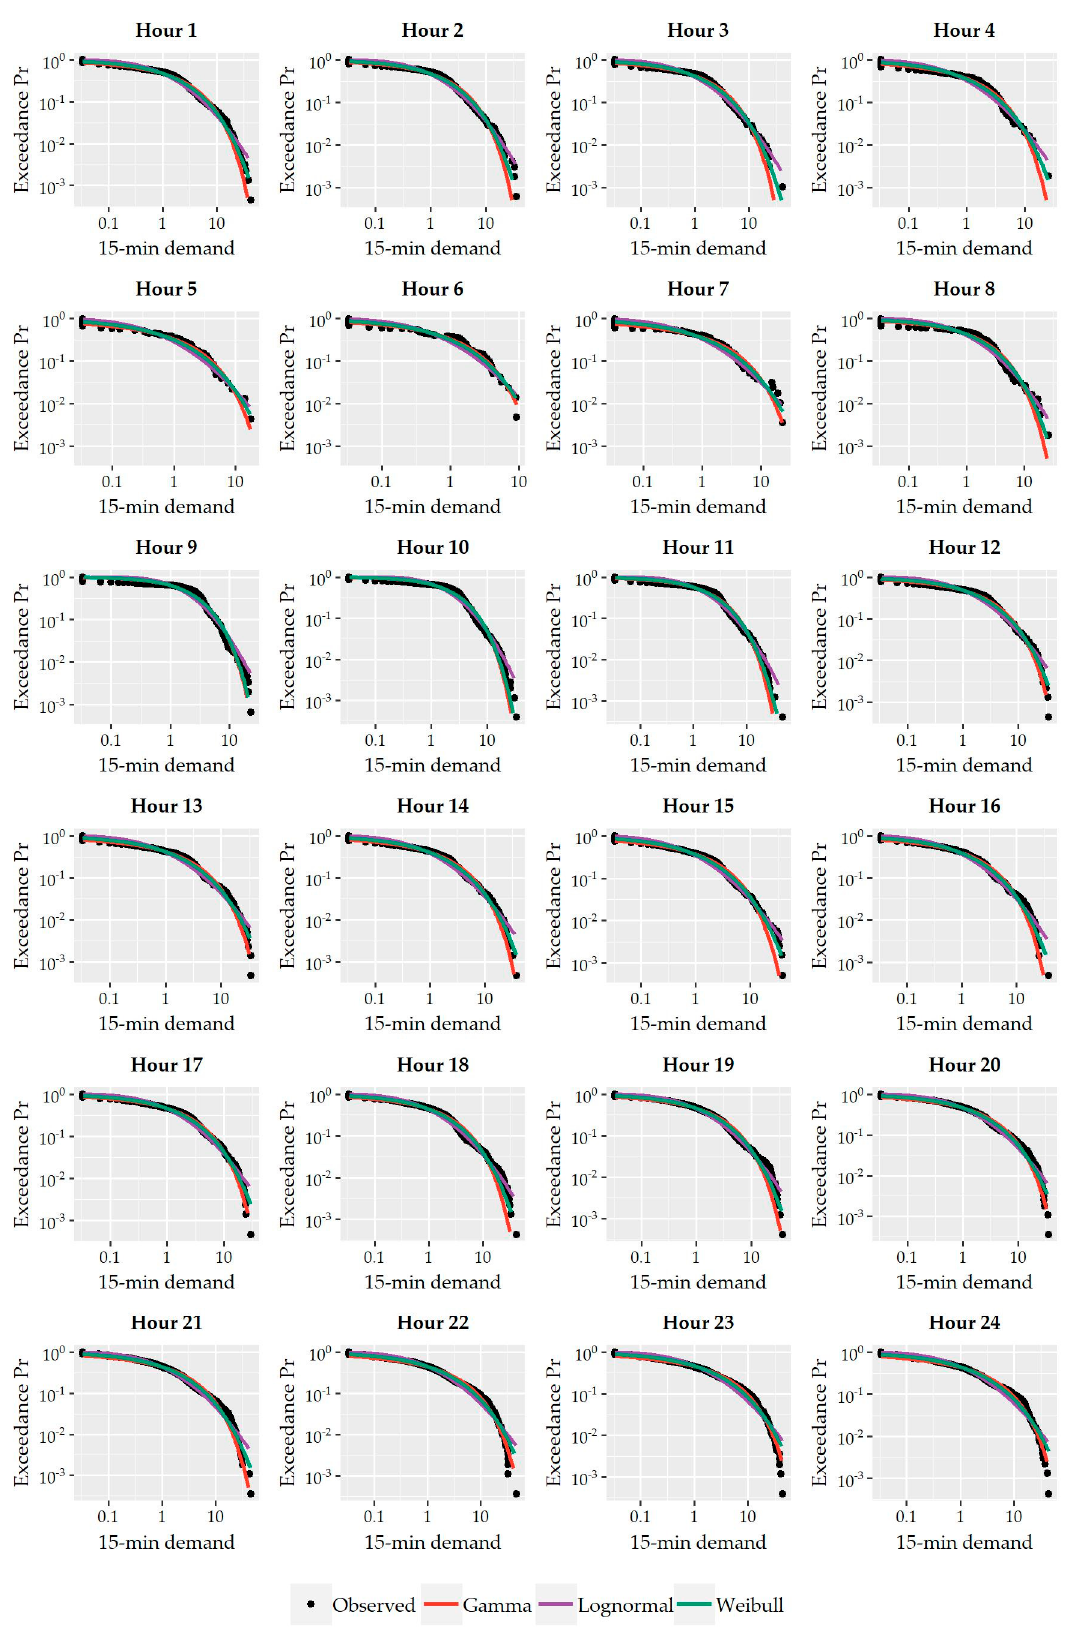
Figure 7. Empirical probability plots per hour of the three fitted distributions to the nonzero 15-minute water demand of House #4.